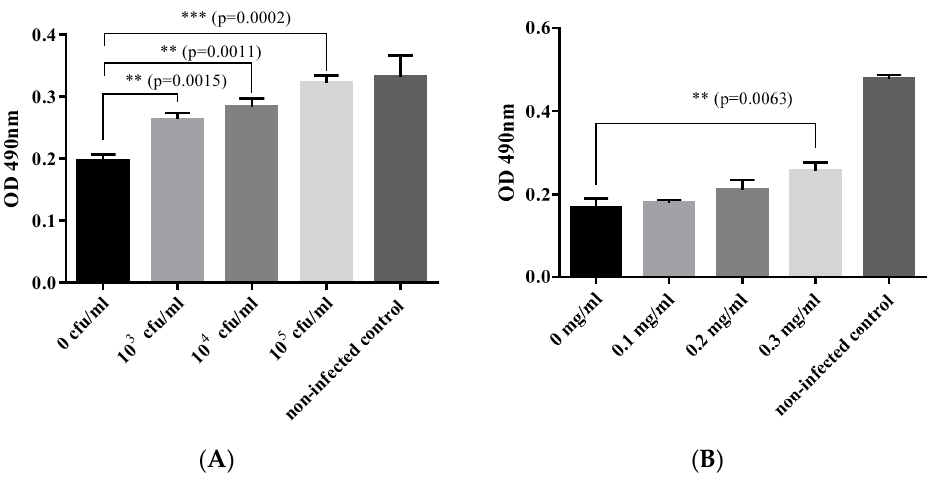
Figure 2. Inhibition of viral hemorrhagic septicemia virus (VHSV) (MOI = 10) infection of olive flounder by B. subtilis ( A ) and surfactin ( B ) determined by the MTT assay (bar chart shows means with the SD, n = 3 plates). ** denote significance level ≤ 0.002 while *** denote significance level ≤ 0.0002.